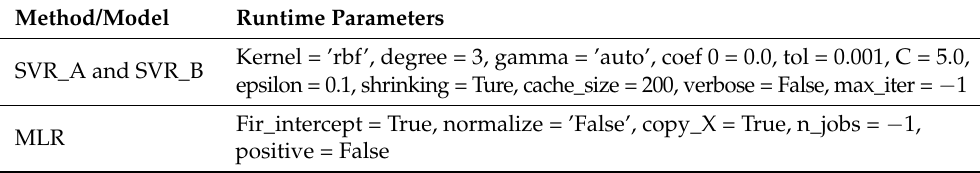
Table 1. Runtime parameters for SVR and MLR models.